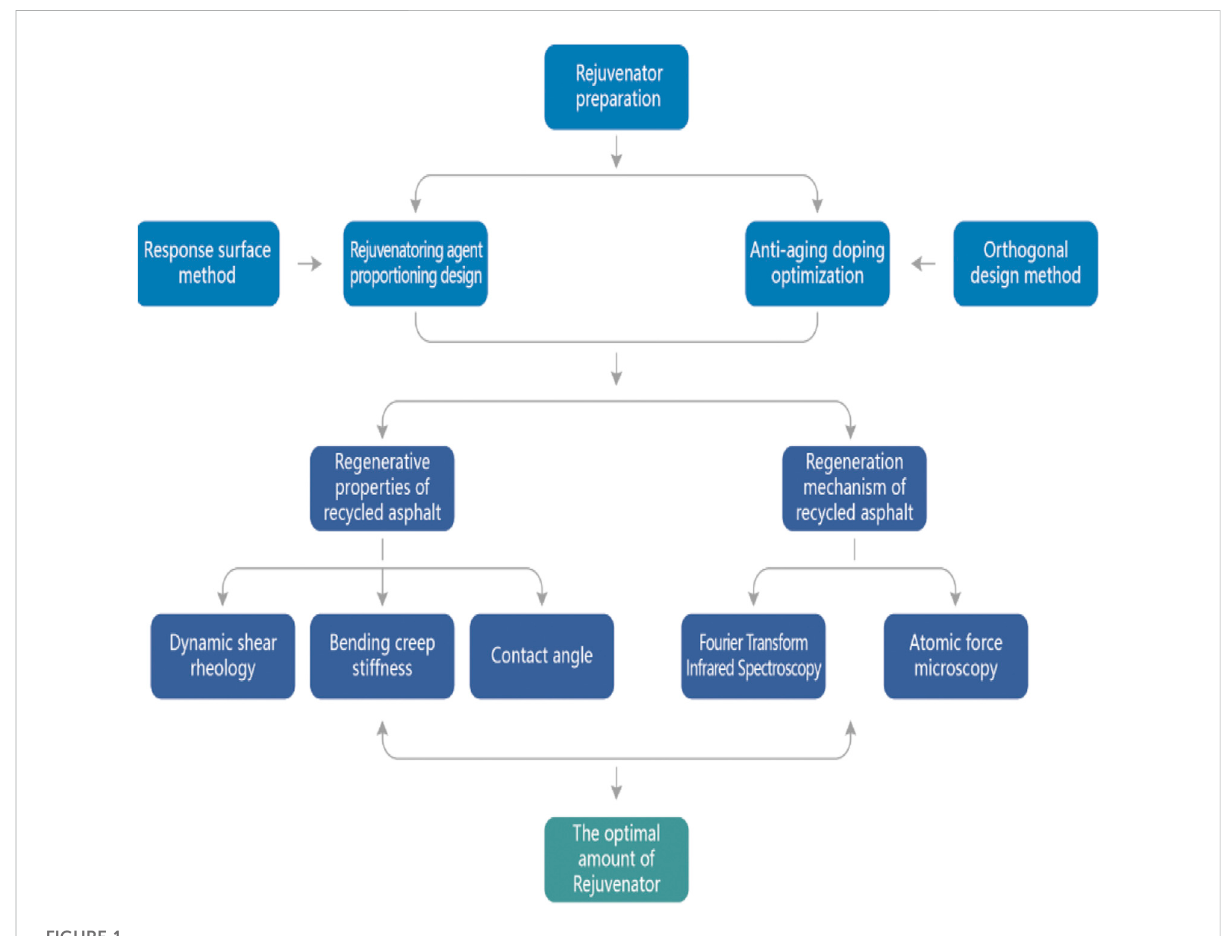
FIGURE 1 Thesis technology